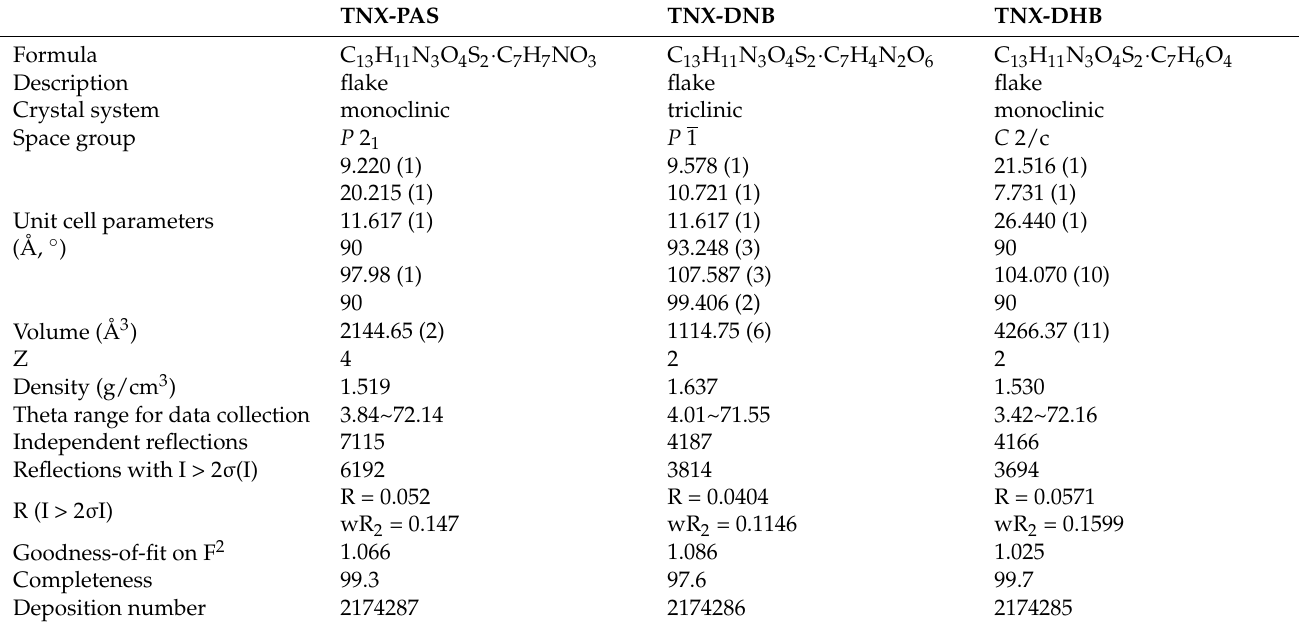
Table 2. Crystal Cell Parameters and Structure Refinement of the Cocrystals or Salt of